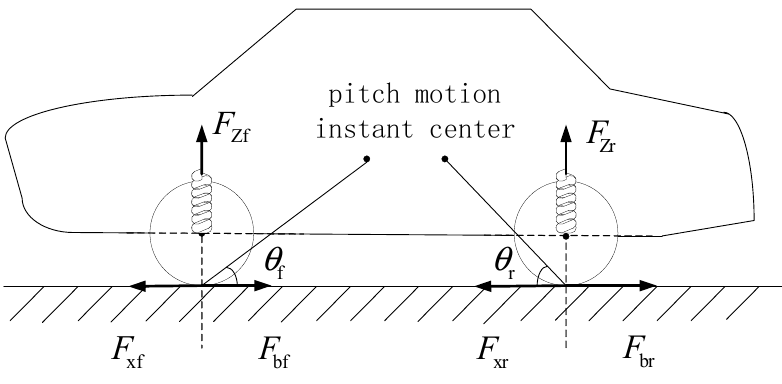
Figure 1. The diagram of additional vertical force.